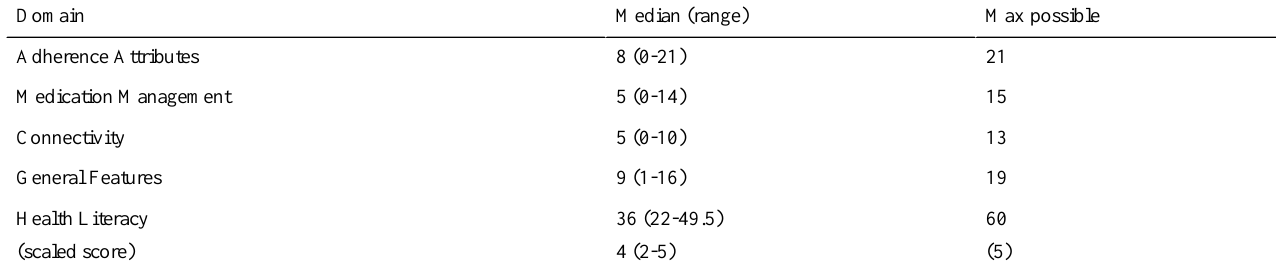
Table 2. Overall user-tested domain